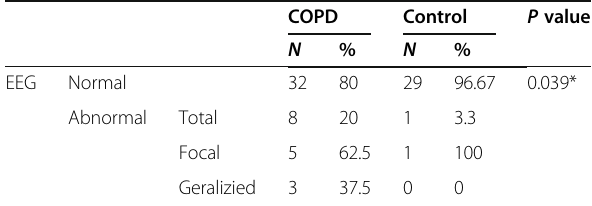
Table 6 EEG results in the studied group